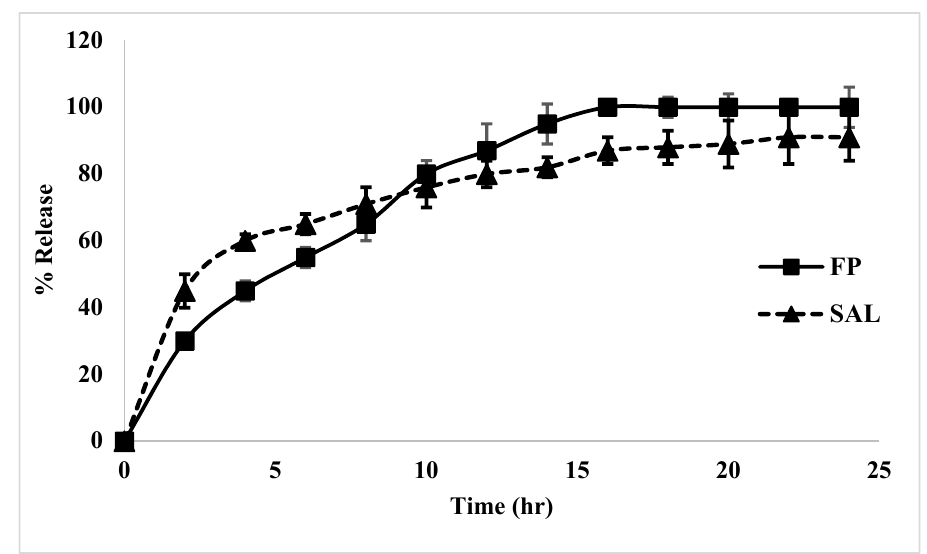
Figure 9. The release profile of FP and SAL from FP-SAL-loaded polymer nanocapsules (F3) for 24 h (mean ± SD, n = 3).